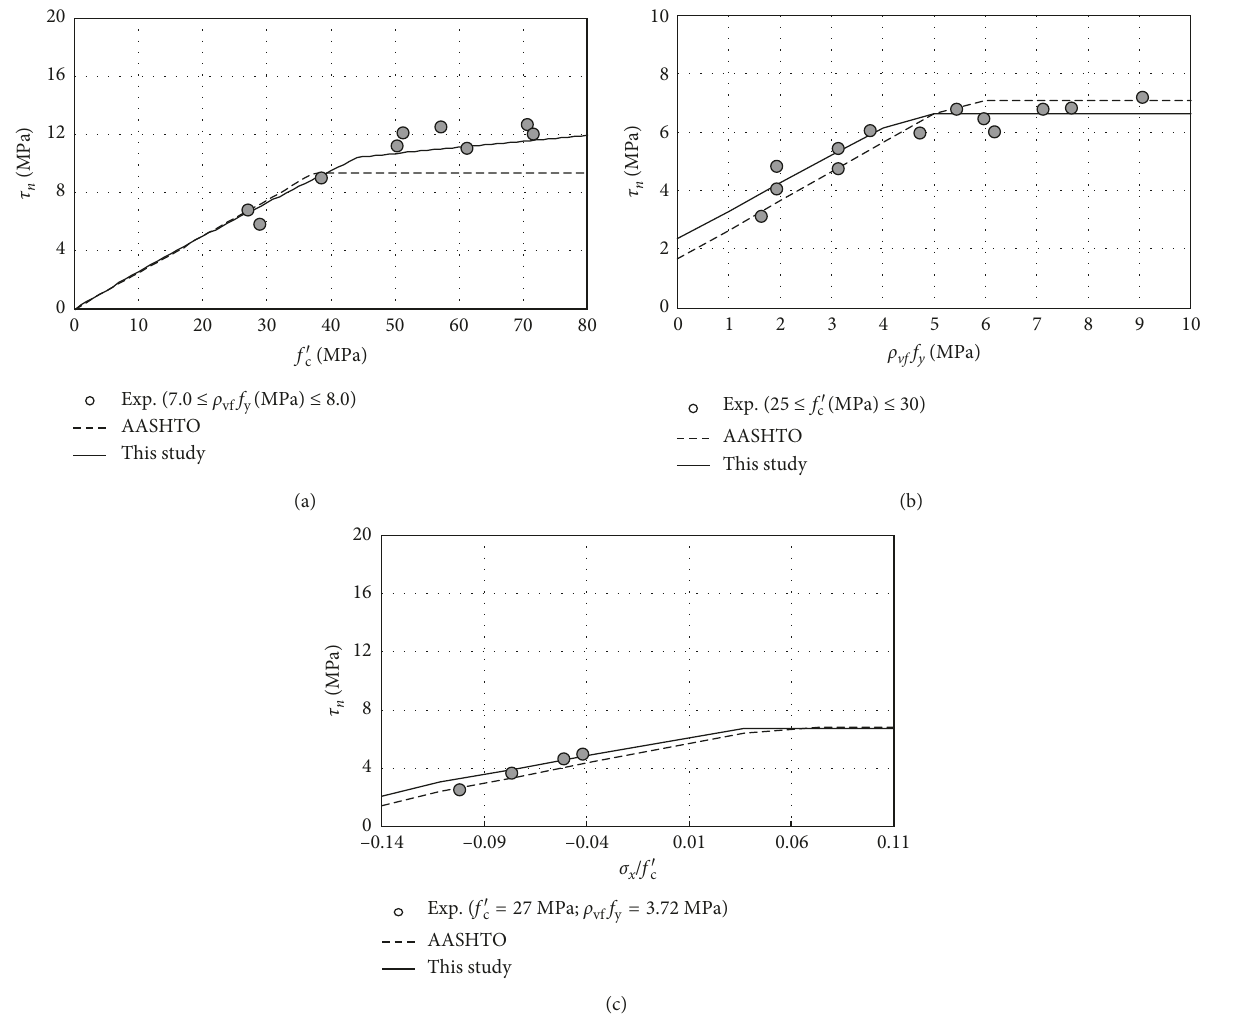
Figure 8: Effects of different parameters on the shear friction strength of construction joints: (a) compressive strength of concrete ( f (b) clamping stress provided by transverse reinforcement ( ρ vf f y ); (c) ratio of applied normal stresses ( σ x ) to f c